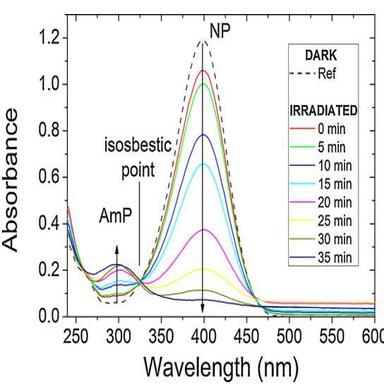
UV–vis absorption spectra during the photocatalytic reduction of 4-nitrophenol with NaBH4 over the TCF nanocomposite catalyst.